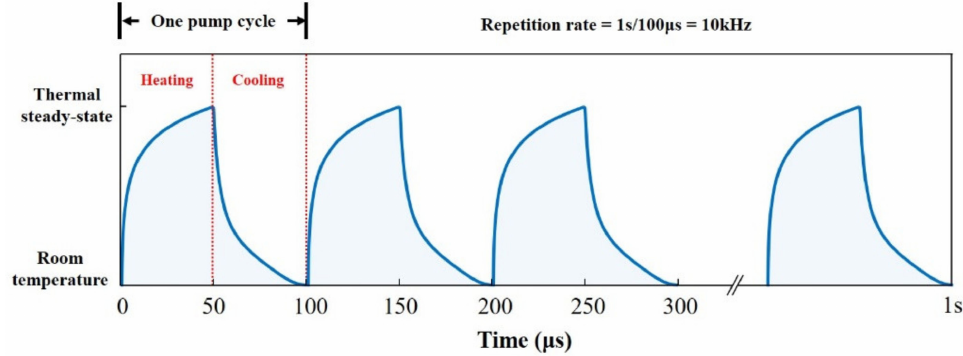
Figure 5. The diagram of temperature change in diamond at repetitive operation without heat